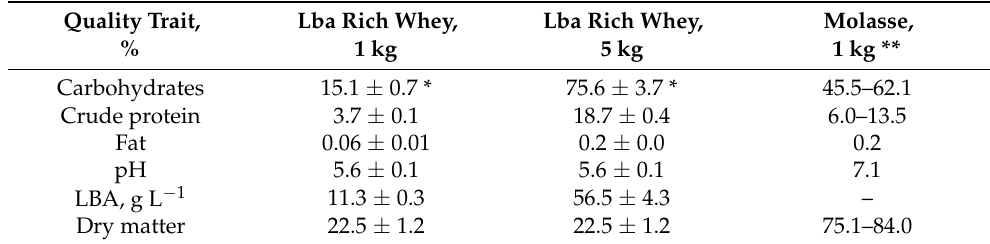
Table 1. Physical–chemical characteristics of prepared lactobionic-acid-rich whey used in the experi- ment as a supplement to the basic feed of lactating